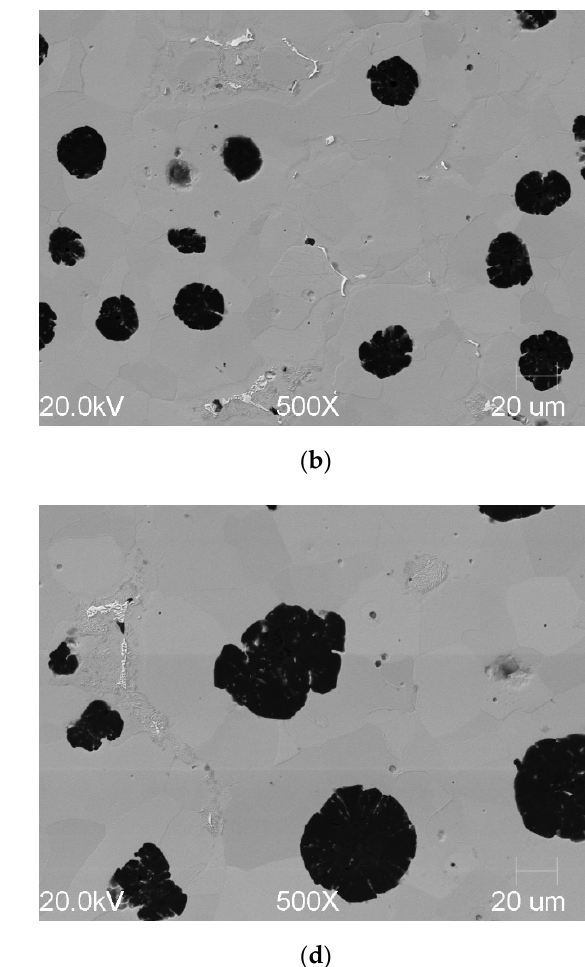
Figure 6. SEM microstructure of investigated ductile iron in intercellular region (g = 13 mm) with visible pearlite and carbides morphology.